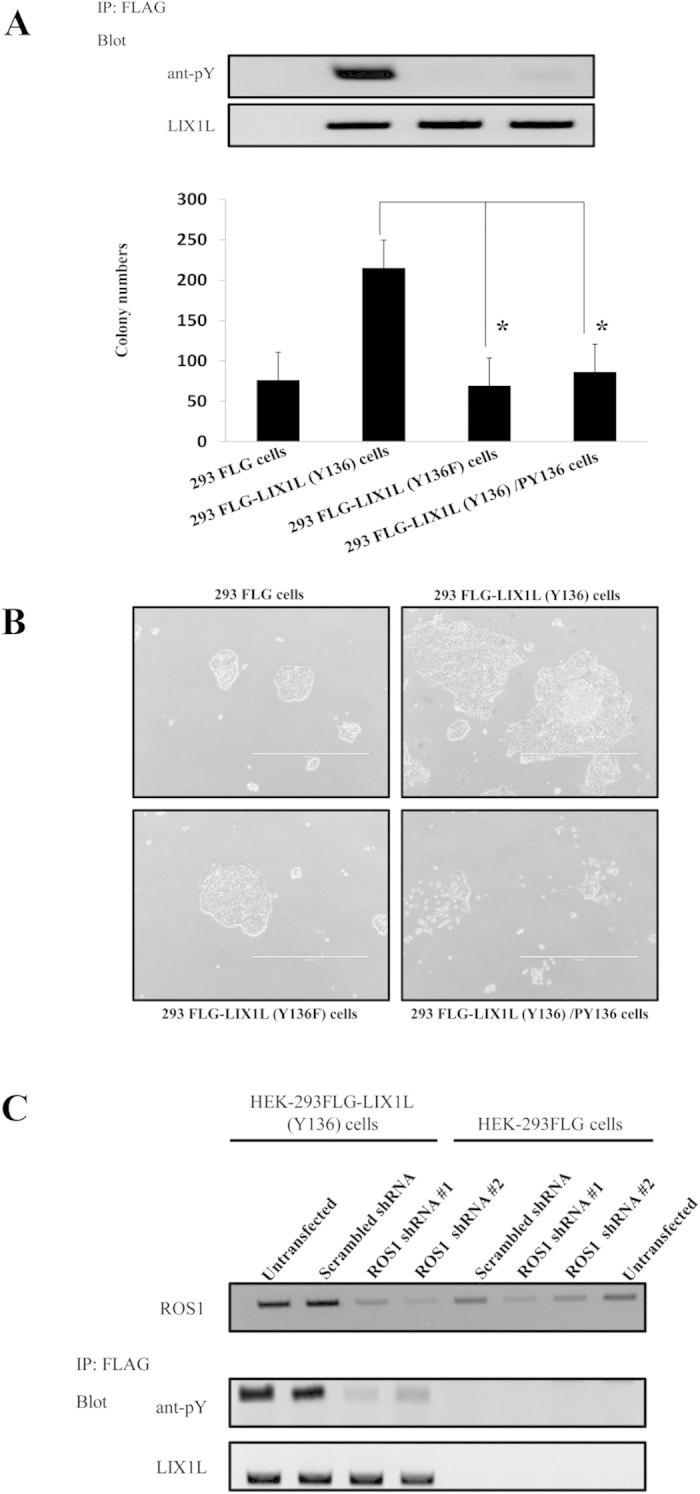
Phosphorylated LIX1L (Y136) promotes cell proliferation.(A) The HEK-293FLG, HEK-293FLG-LIX1L (Y136) and HEK-293FLG-LIX1L (Y136F) cells were cultured in semisolid methylcellulose media. The HEK-293FLG-LIX1L (Y136) cells were left untreated or were treated with PY136 (25 μM). After 14 days in culture, colony formation was analyzed, and the cells were viewed using phase-contrast microscopy. The colonies formed from each cell type (3 × 102 to 5 × 102 cells/plate) were counted following plating in semisolid methylcellulose media and the phosphorylation levels of LIX1L were analyzed through western blotting. The phosphorylation level of LIX1L was decreased compared with that in LIX1L (Y136) cells. The blots were run under the same experimental conditions. These data are shown as the mean ± SD for independent experiments. *p < 0.01. (B) The representative microscopic images of each colony are shown. Original magnification 4x. (C) HEK-293FLG and HEK-293FLG-LIX1L (Y136) cells were transfected with scrambled shRNA, ROS1 shRNA-#1 or -#2, and the phosphorylation level of LIX1L was assessed. The blots were run under the same experimental conditions.